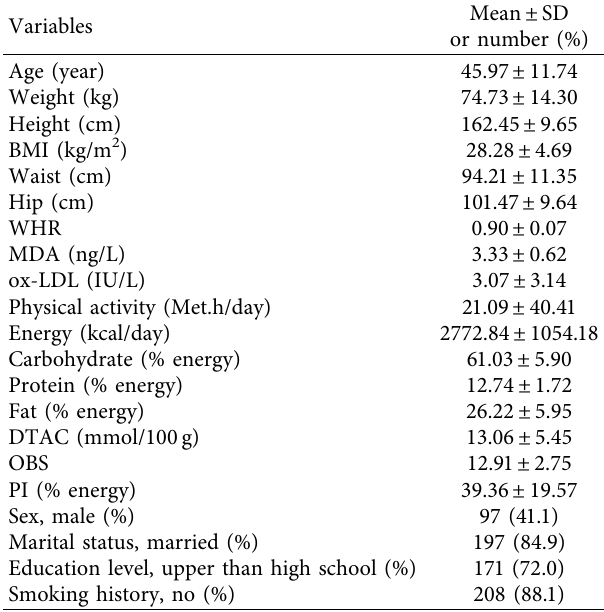
Table 2: Baseline characteristics of the study